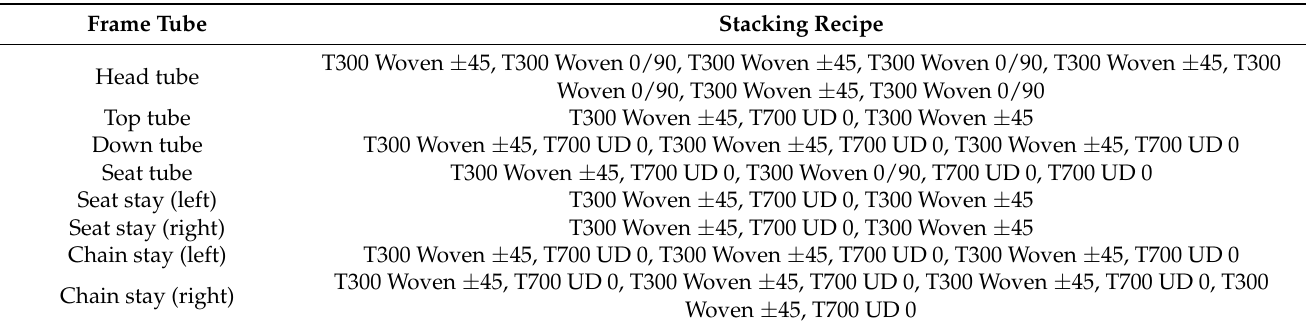
Table 7. Stacking scenario 4.